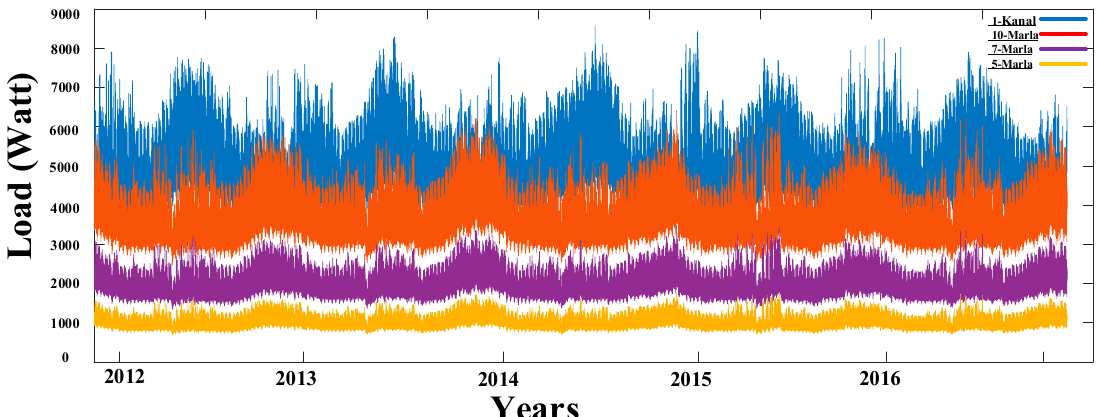
Figure 1. Residential load pattern for different house categories.